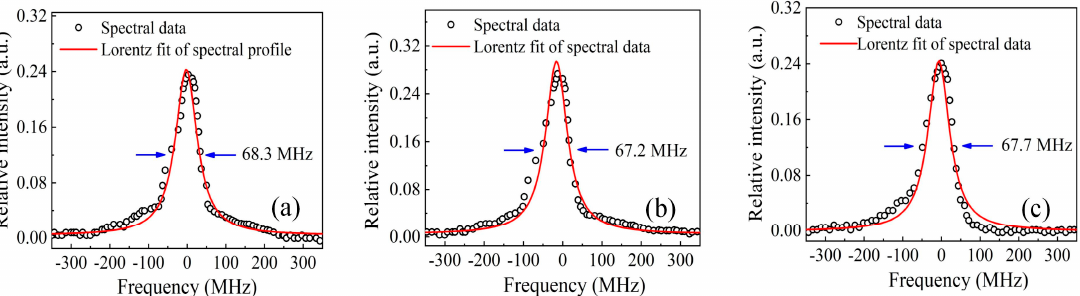
Figure 8. Time-averaged spectral profile of pulse burst MOPA laser for variable pulse width over 4 ms uniform envelope: ( a ) At 100 ns pulse duration; ( b ) At 200 ns pulse duration; ( c ) At 300 ns pulse duration.